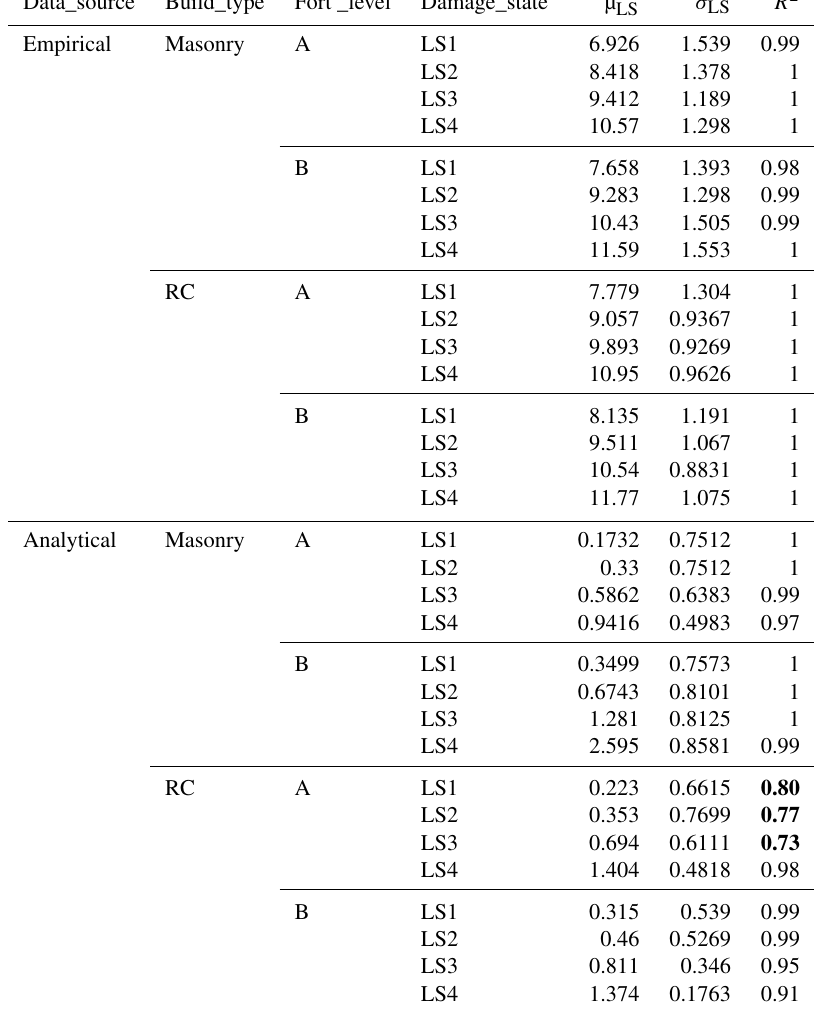
Table 4. The median fragility curve parameters regressed from empirical and analytical fragility data. The three values in bold font indicate the low quality of the correspondingly regressed fragility curves (see Sect. 4 for more